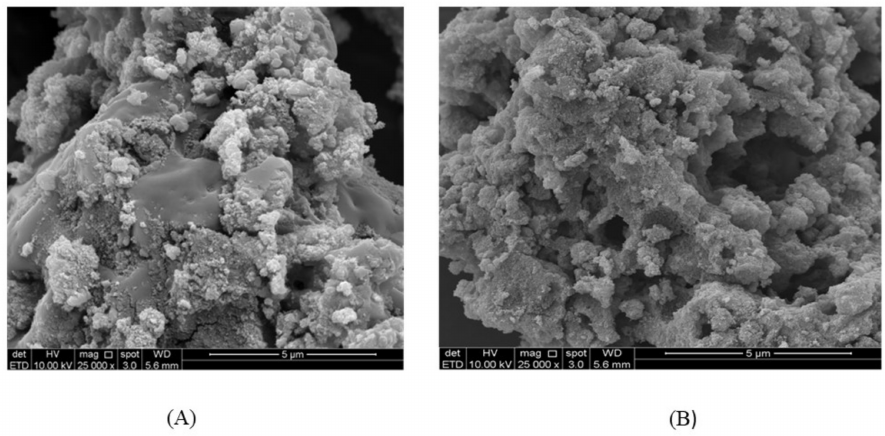
Figure 4. SEM images of the sorbent material: ( A ) before adsorption; ( B ) after